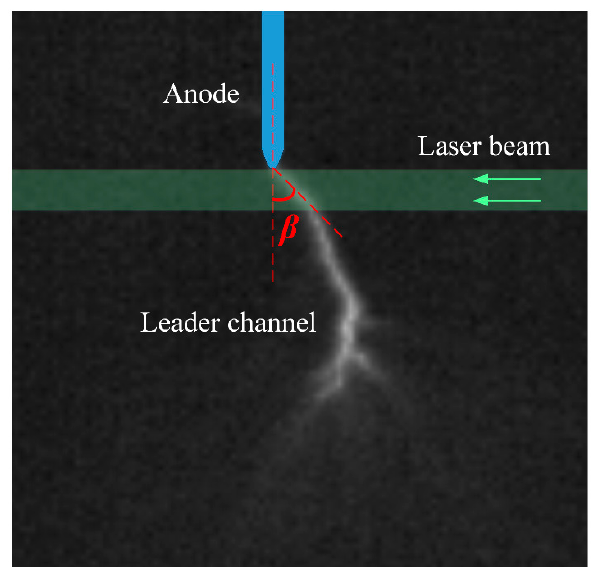
Figure 3. Diagram of β , which is the angle between the leader channel and the vertical axis